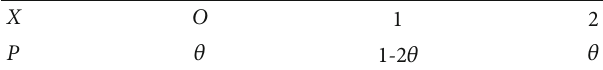
Table 4: Probability